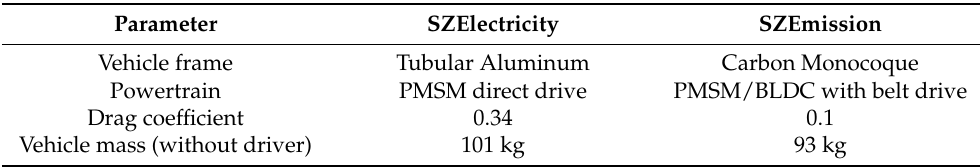
Table 1. Vehicle parameters.